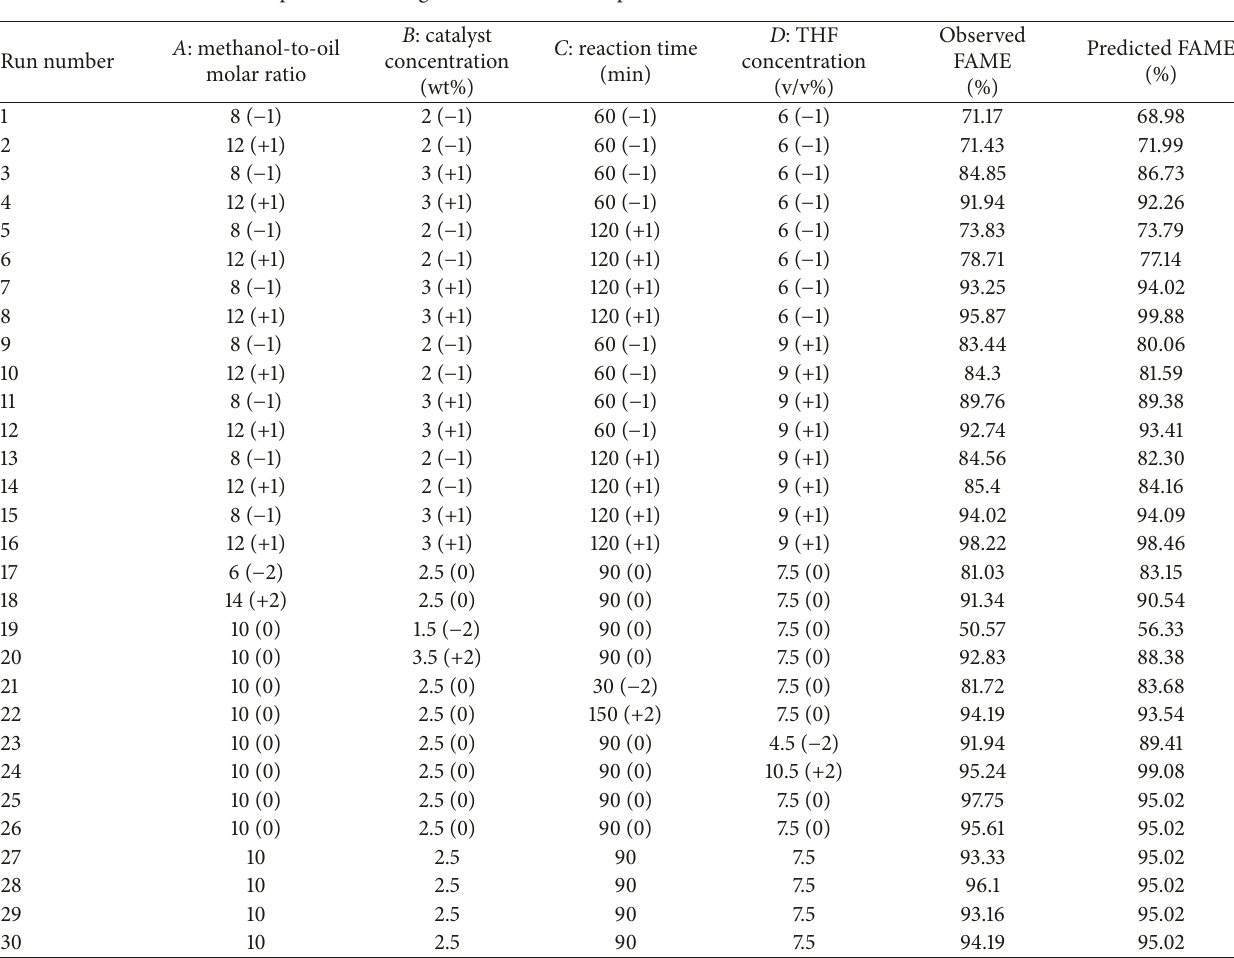
Table 2: Experimental design with observed and predicted values from transesterification of